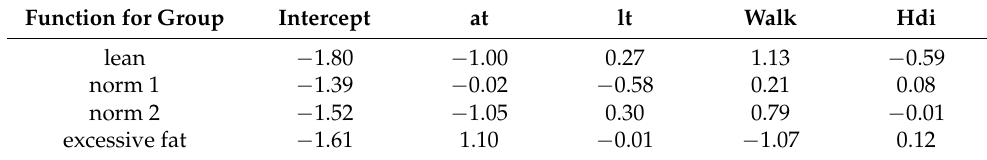
Table 4. The coefficients of the classification functions (calculated for each BFP group). Function for Group Intercept